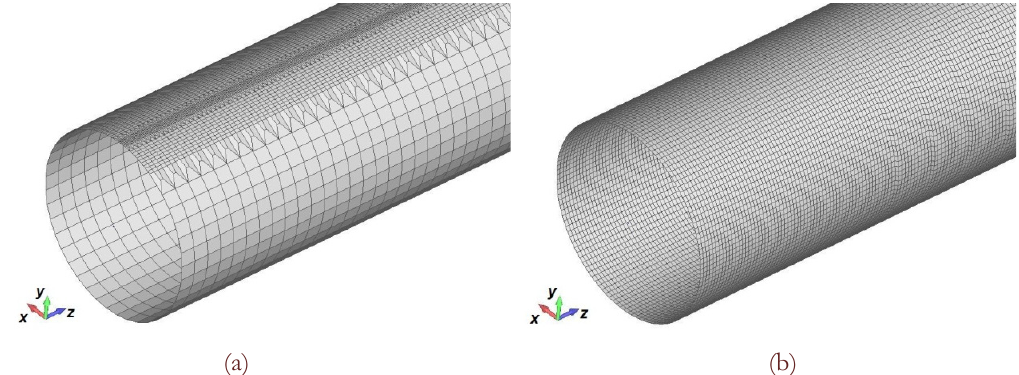
Figura 8: Mesh ad infittemento circonferenziale (a); Mesh ad infittemento assiale progressivo (b). La mesh di Fig. 8a è composta da 10320 elementi e 10951 nodi, e presenta un infittimento progressivo delle maglie in